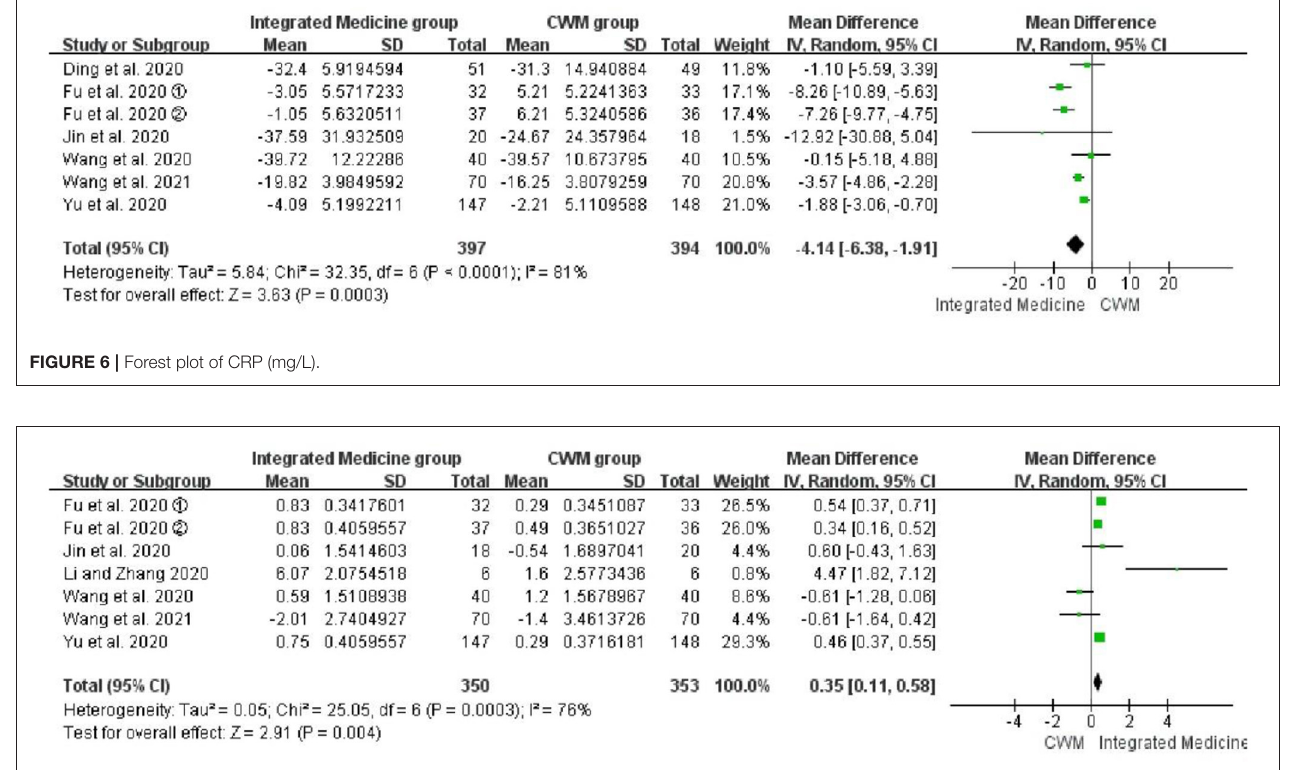
FIGURE 7 | Forest plot of white blood cell (10 9 /L) count.